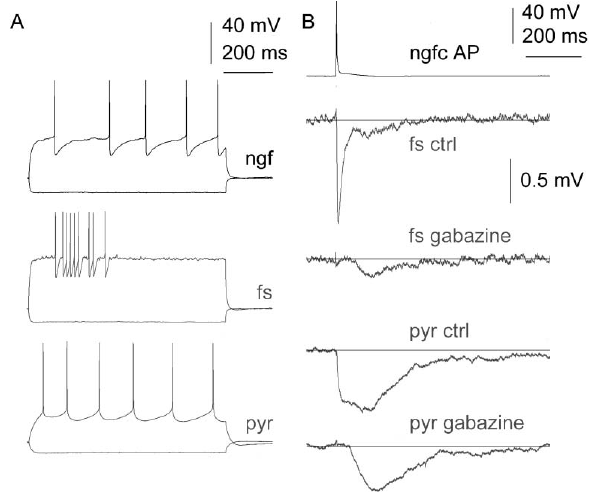
Figure 5. Divergent connections of a neurogliaform cell (ngfc) to post- synaptic fast spiking (fs) and pyramidal (pyr) cells . ( A ), Firing properties of the recorded cells. ( B ), Single action potentials in the neurogliaform cell elicited IPSPs with complex kinetics in the fast spiking as well as in the pyra- midal cell. A residual slow component was detectable in both postsynaptic neurons during application of the GABAA receptor blocker gabazine (10 µ M).